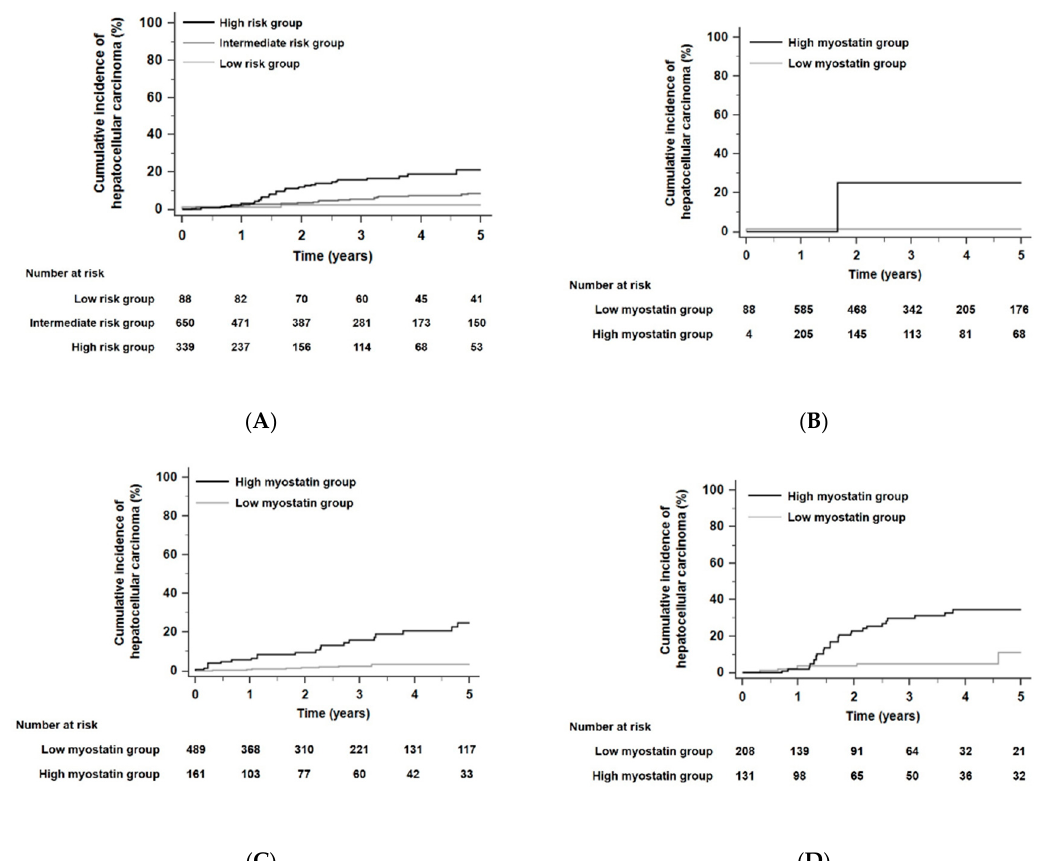
Figure 2. Kaplan–Meier estimates of HCC development in ALC patients according to the Toronto HCC risk index (THRI). ( A ) Risk stratification for HCC development in ALC patients according to the THRI ( p < 0.001 by log-rank test). ( B ) Risk stratification for HCC development according to serum myostatin levels in the low risk group stratified by the THRI; ( C ) in the intermediate risk group; ( D ) in the high-risk group (all, p < 0.05 by log-rank test). Abbreviations: ALC, alcoholic liver cirrhosis; THRI, Toronto HCC risk index; HCC, hepatocellular